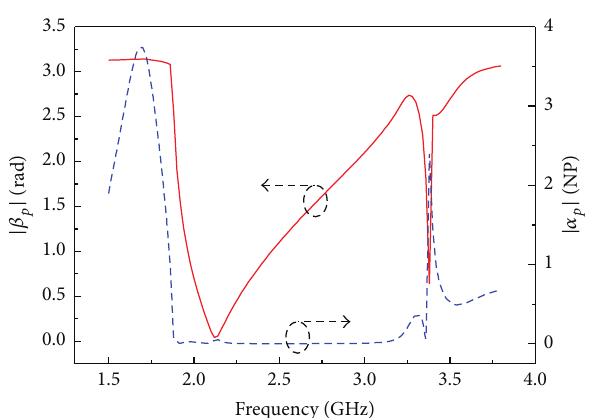
Figure 6: Dispersion characteristic diagram of the designed filter with improved CRLH